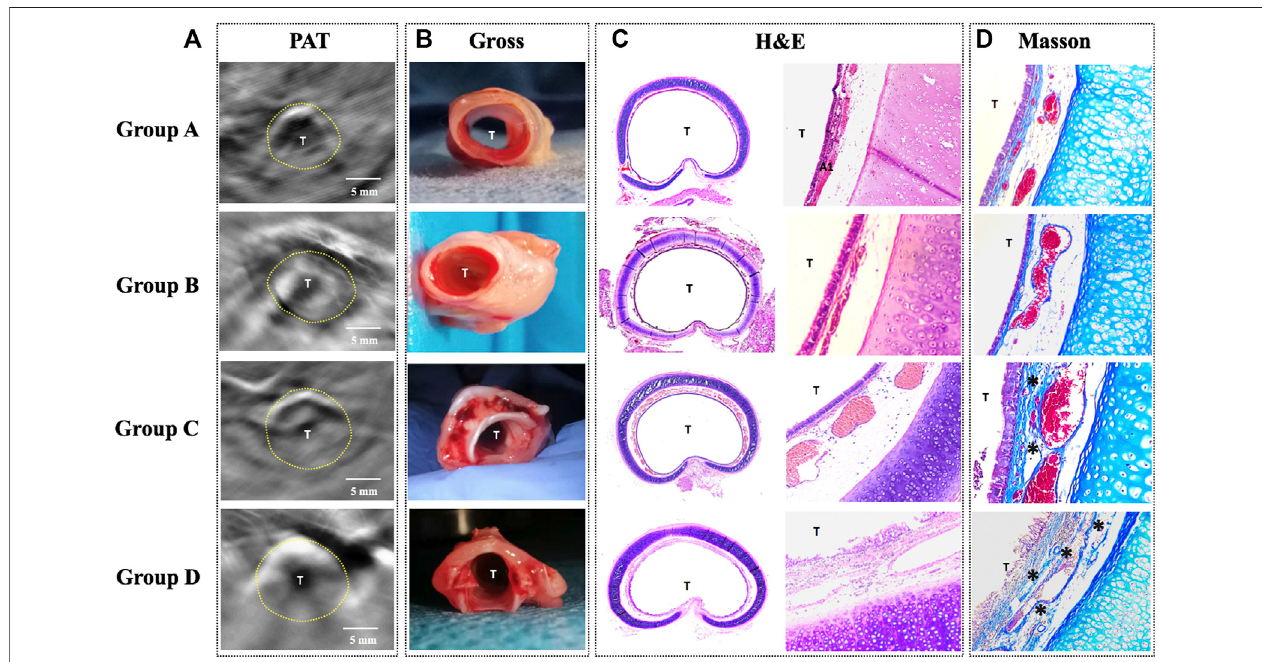
FIGURE 5 | Comparison of PAT images and the corresponding histology in four groups. (A) PAT image acquired at 760 nm wavelength. (B) Gross tissue specimen. (C) Histologyofthecross-sectionaltracheawithHEstaining(×40/×100). (D) HistologyofthetracheawithMassonstaining(×100)showingincreasedcollagen distribution (*). PAT, photoacoustic tomography; Gross, gross examination; H&E, hematoxylin and eosin staining; Masson, Masson staining; T, tracheal lumen Dotted line: trachea. Scale bars are 5 mm long.